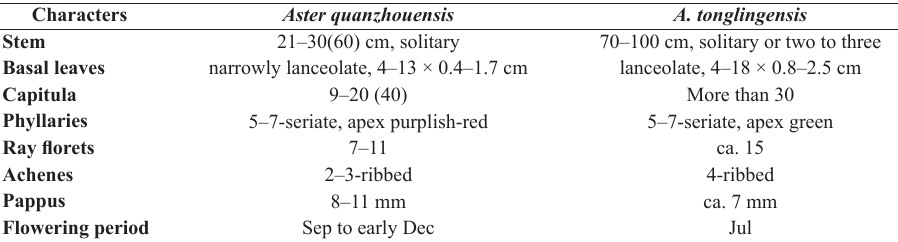
Table 1. Comparison of Aster quanzhouensis and A. tonglingensis . The data of the latter species were taken from Zhang et al.